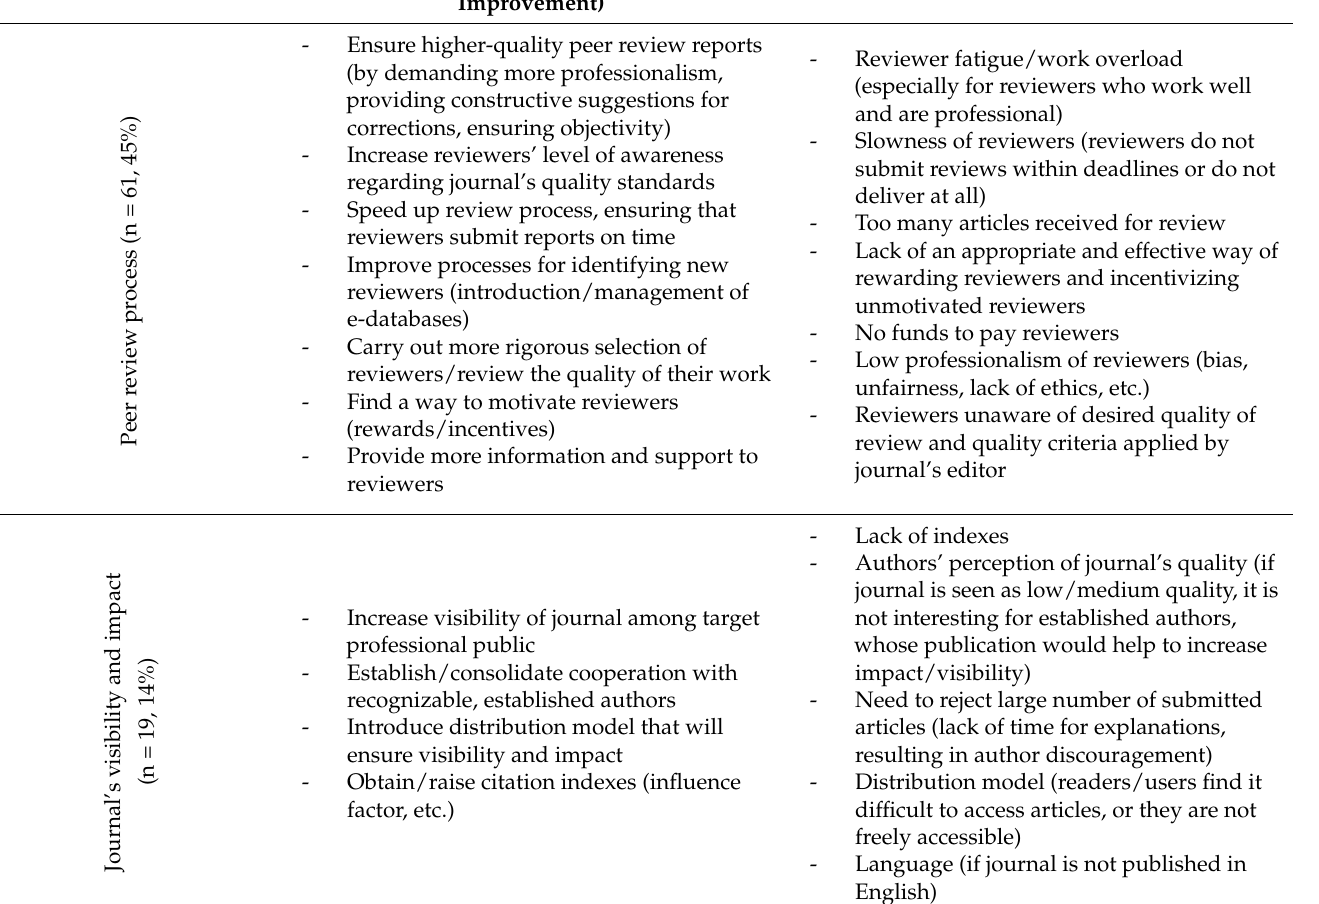
Table 10. Respondents’ perceptions of needed improvements to enhance overall quality of journal and anticipated